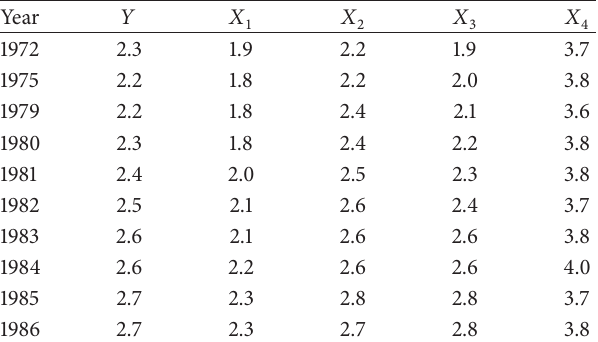
Table 1: Total Research and Development Expenditures as a percent of Gross National Product by Country: